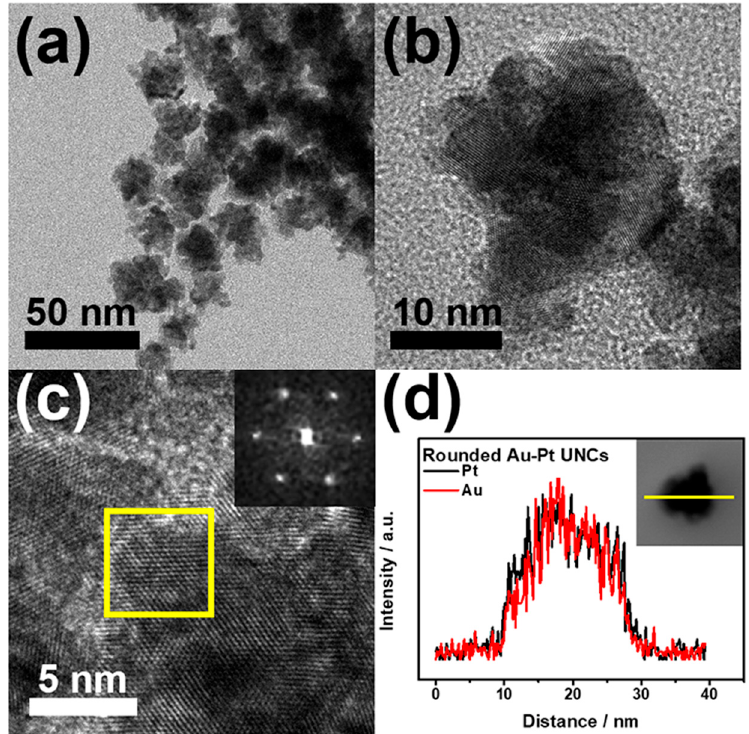
Figure 7. ( a ) TEM images of rounded Au–Pt UNCs. ( b ) TEM; and ( c ) high-magnification TEM images of a rounded Au–Pt UNC. The insets in ( c ) show an FFT pattern obtained from a rounded Au–Pt UNC. ( d ) Cross-sectional compositional line profiles of a rounded Au–Pt UNC.